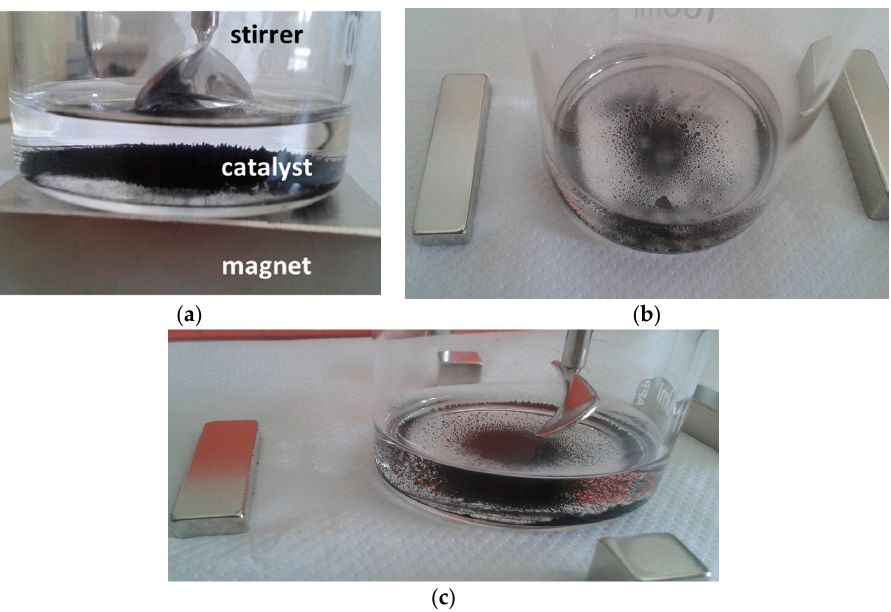
Figure 2. Cyclohexane oxidation reaction performed under different external NdFeB magnetic fields. ( a ) One magnetic block N40 grade; ( b ) Two magnetic blocks N42 grade; ( c ) Two magnetic blocks N42 grade, a magnetic cube N42 grade, and a magnetic cube N48 grade. Table 3. Selected data a for the cyclohexane oxidation with TBHP using [FeCl 2 {HC(pz) 3 }] + Fe 3 O 4 ( 2 ) as catalyst, under an external magnetic